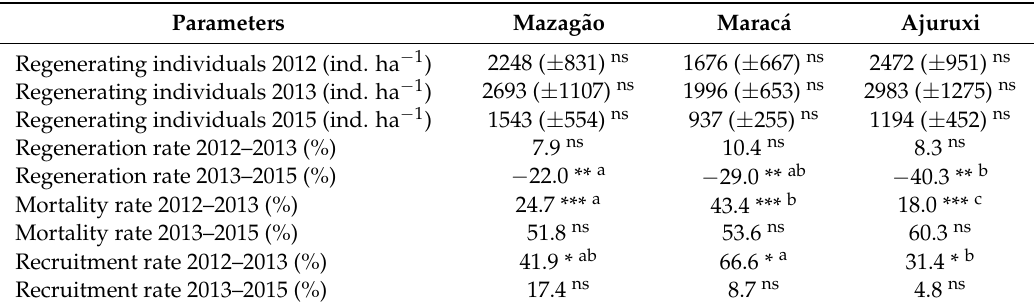
Table 1. Density and demographic rates of regenerating individuals of Mora paraensis (height > 50 cm, diameter at breast height (DBH) < 5 cm), inventoried in floodplain forest in three regions (Mazag ã o, Marac á , Ajuruxi) of the eastern Amazon in 2012, 2013 and